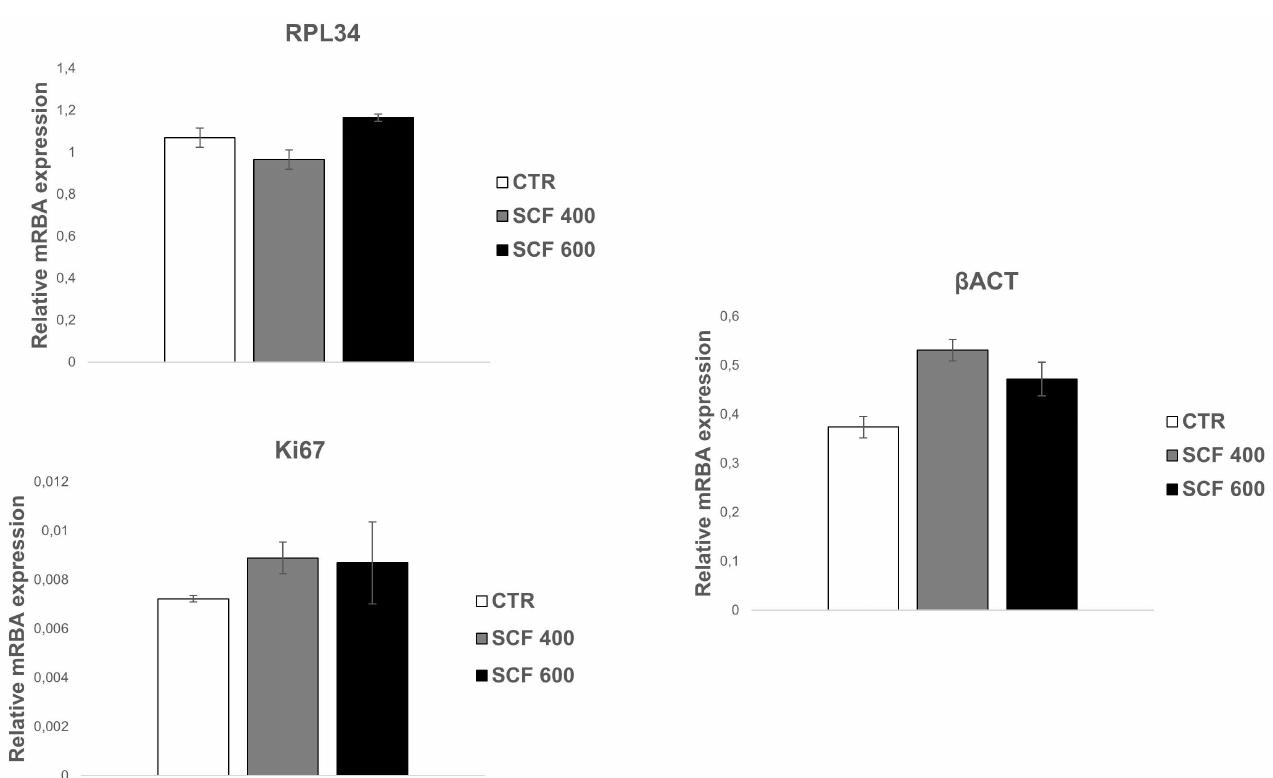
Figure 3. qRT-PCR analysis of SAOS-2 key gene expression. The housekeeping genes (constitutive gene) β -ACT, Ki67, and RPL34 were investigated in SAOS-2 cells grown on SCF 400 scaffolds, SCF 600 scaffolds, and compared to PLA control (CTR). Data are shown as mean SD. Osteogenesis is a multistep series of events modulated by an integrated cascade of gene expression characterized by three orderly stages: (1) proliferation; (2) extracellular matrix (ECM) deposition and maturation; and (3) mineralization of the bone ECM [29]. These phases are accompanied by the activation of transcription factors, including RUNX2 and specific genes associated with the osteoblast phenotype, such as alkaline phosphatase (ALP), osteocalcin (OCL), and osteopontin (OPN). ALP is considered a marker of early differentiation, which is expressed at the end of the proliferative period and during depo- sition and maturation of the ECM. Both OPN, the main phosphorylated glycoprotein of bone, and OCL, a highly conserved small molecule, are expressed during the last phase of osteogenesis, which is associated with mineralization of the bone matrix [30].